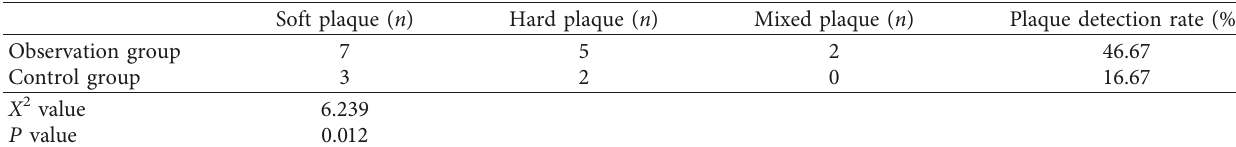
Table 2: Comparison between carotid atherosclerosis plaque of the two groups.